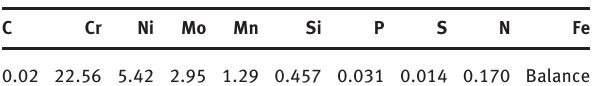
Table 2: The chemical composition of SAF 2205 duplex stainless steel (wt.%).